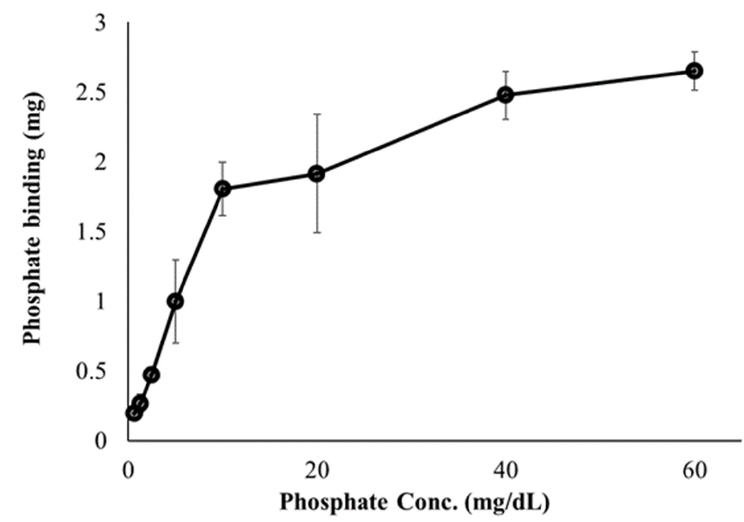
Figure 3. Effect of phosphate concentrations on phosphate binding by FC liposomes. FC liposomes (1 mL w/1.22 mg FC) were incubated with phosphate solutions at increasing concentrations for 24 h. Phosphate ion binding ability was evaluated by measuring phosphate concentrations in solutions before and after 24 h incubation with FC liposomes. Results presented as mean (of 3 samples) ± SD. Statistical significance was determined by one-way ANOVA with Tukey’s HSD test for multiple comparisons.